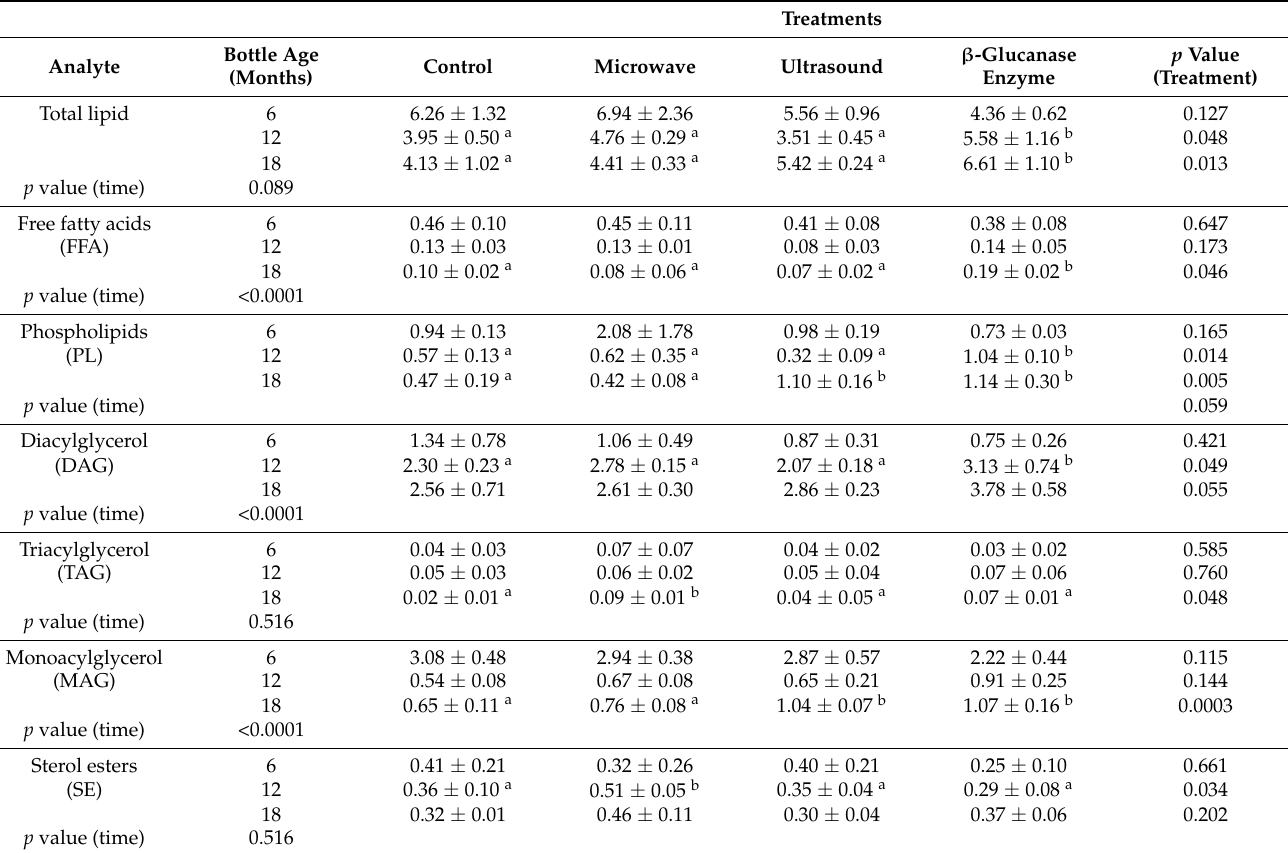
Table 3. Lipid composition 1 ( µ g mL − 1 ) of sparkling wines after 6, 12 and 18 months ageing.